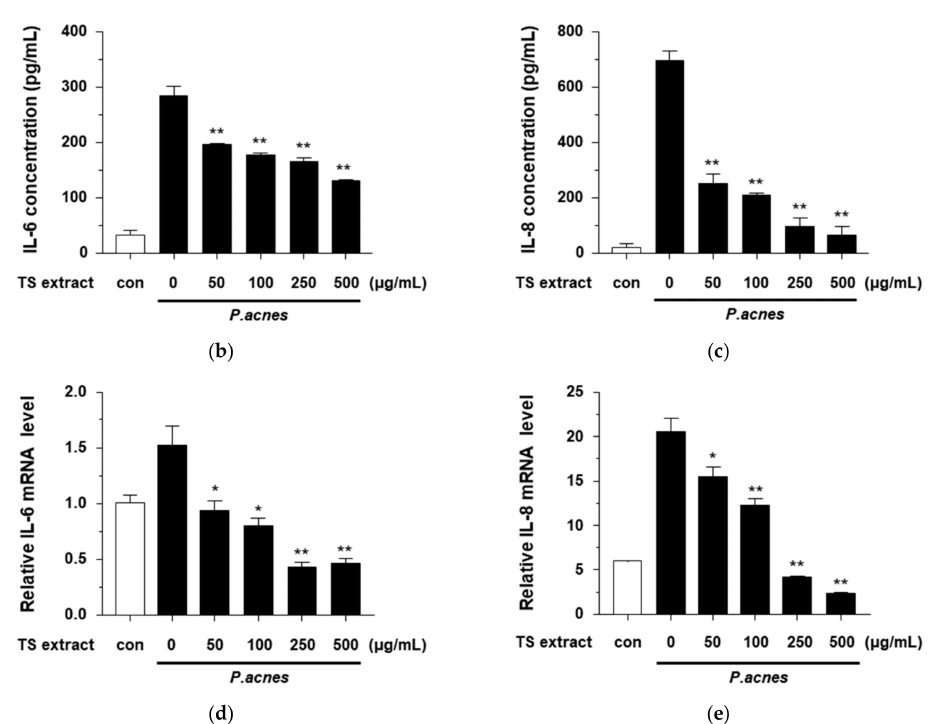
Figure 5. Anti-inflammatory e ff ects of TS extract in P. acnes -treated HaCaT cells. ( a ) Cells were treated without or with indicated concentrations of TS extract and cell viability was determined by MTT assay; ( b ) Cells were pretreated with indicated concentrations of TS extract for 4 h and then treated with P. acnes for 18 h. Secretion level of IL-6 was determined by ELISA kit; ( c ) Secretion level of IL-8 was determined by ELISA kit; ( d , e ) Relative mRNA levels of IL-6 and IL-8 were determined by real-time PCR. Values are expressed as mean ± SD of three independent experiments; * p < 0.05; ** p < 0.001 vs. P. acnes alone.